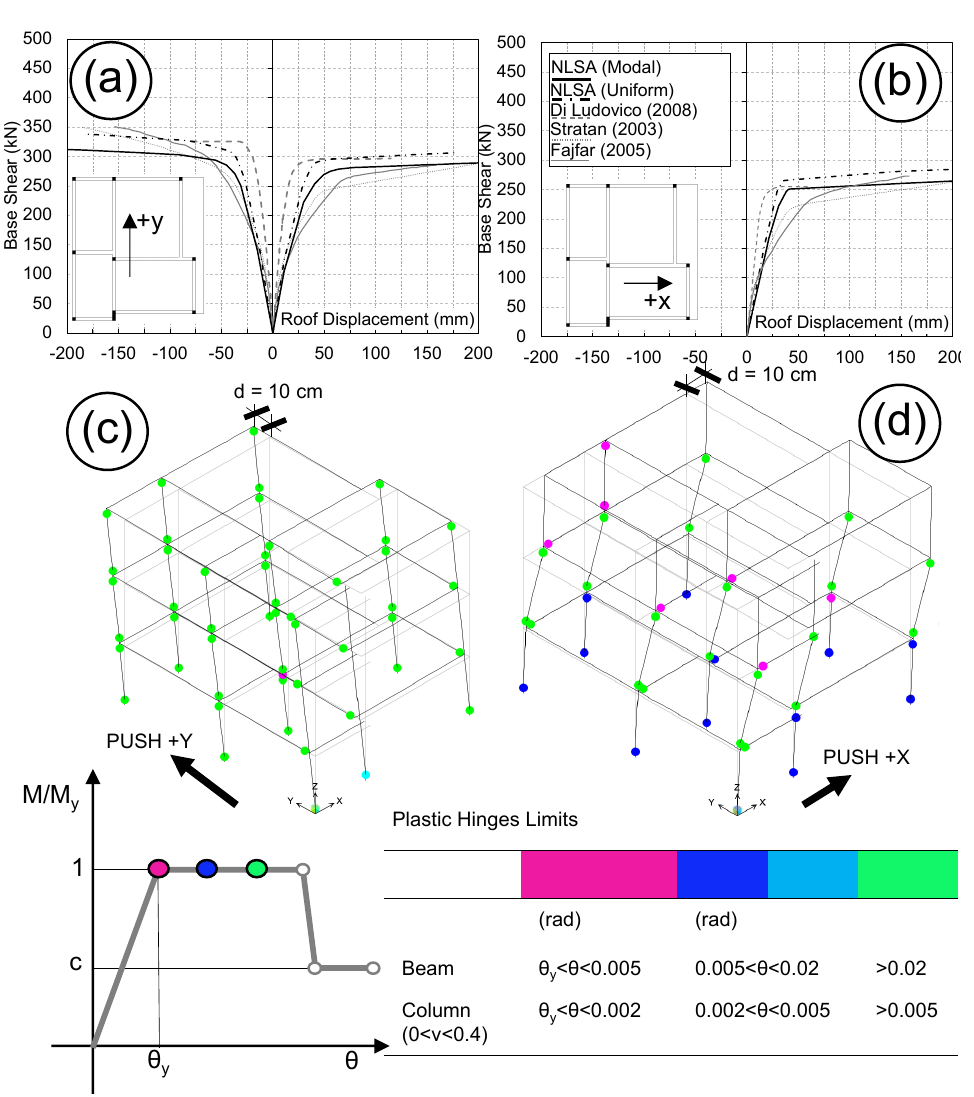
Figure 13. Validation of NLSA applied to the SPEAR frame: ( a , b ) capacity curves in y and x directions, respectively; ( c , d ) plastic hinges rotation at 10 cm roof displacement in y and x–directions, respectively. The Reader is referred to the color version of this